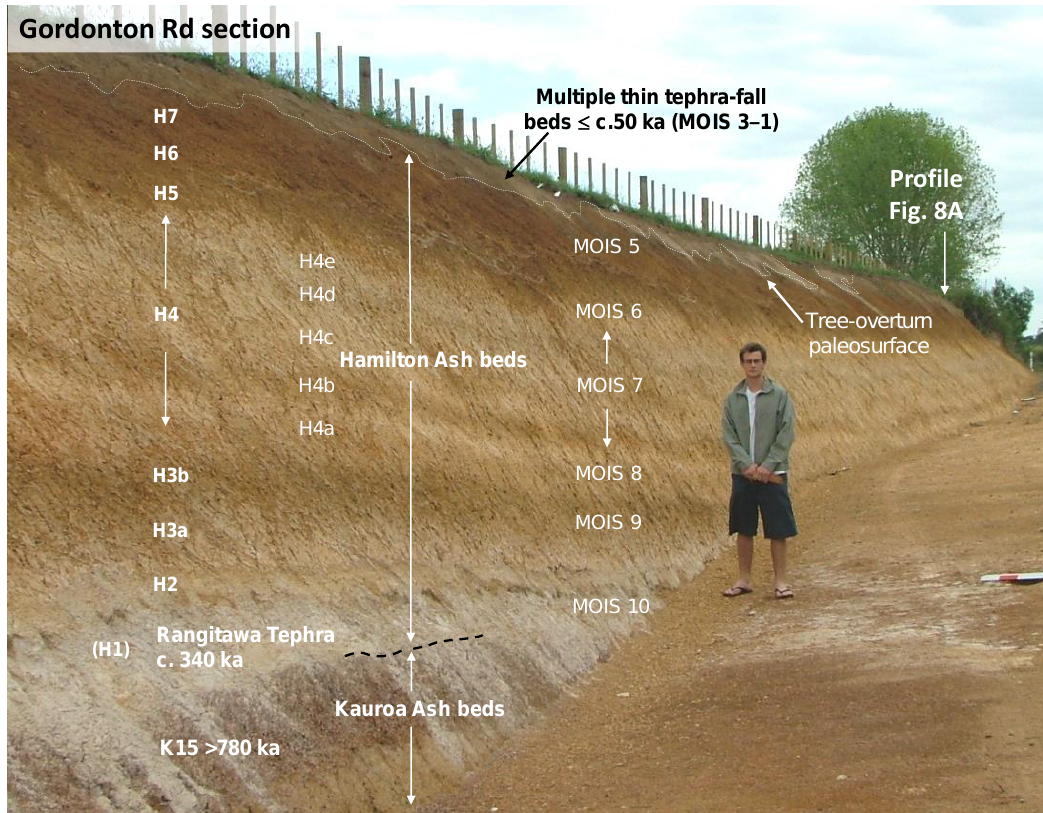
Figure 3. A long section of weathered tephras, including the Hamilton Ash (H) beds (designations follow [61]), exposed in a road cut on Gordonton Road (37 ◦ 42 (cid:48) 21” S, 175 ◦ 18 (cid:48) 14” E) about 3 km north of Hamilton (Figure 1). The dark reddish-brown soil horizons on uppermost Hamilton Ash (H6/7) probably reflect pedogenesis in the Last Interglacial or Marine Oxygen Isotope Stage (MOIS) 5e [55], a New Zealand equivalent of the Sangamon paleosol/geosol of North America (e.g., [24,62,63]). Above the unconformable boundary (marked by the upper dashed line) is a thin (c. 0.6 m on average but quite variable), silty coverbed of multiple, intermixed late Quaternary tephras that have accumulated incrementally over the past c. 50 ka. The undifferentiated coverbed m é